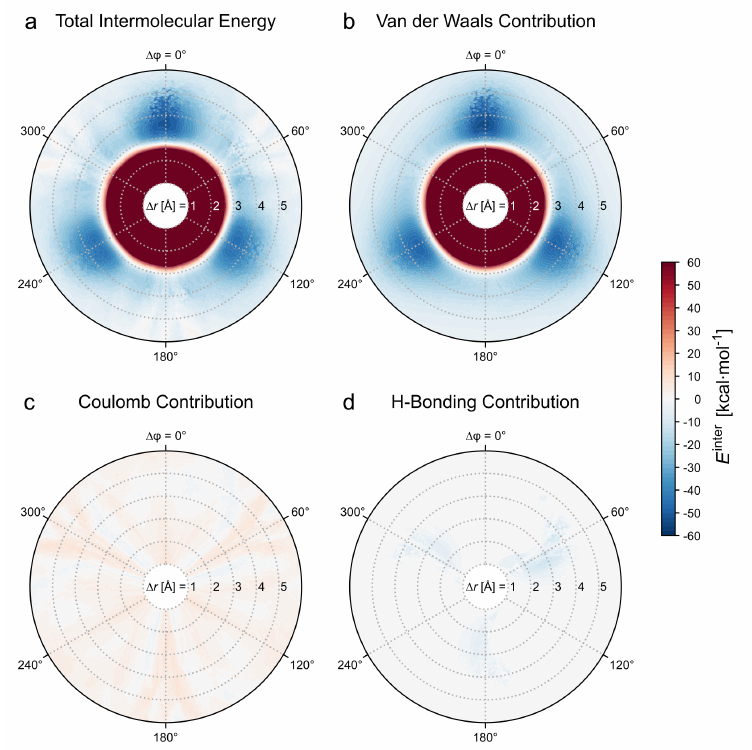
Figure 3. ( a ) Total intermolecular energy of a TrisAzo dimer and ( b – d ) its decomposition into contri- butions due to non-covalent interactions: ( b ) van der Waals interactions, ( c ) Coulomb interactions, and ( d ) hydrogen bonding. All plots employ the same energy scale. The color scheme corresponds to the one in Figure 2b. The empty (white) area at ∆ r < 1Å indicates the absence of data in this distance